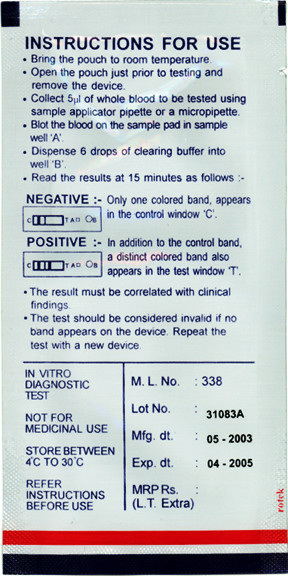
Manufacturer's instructions for the Paracheck Pf® rapid diagnostic test. Actual size: 6.6 × 13 cm